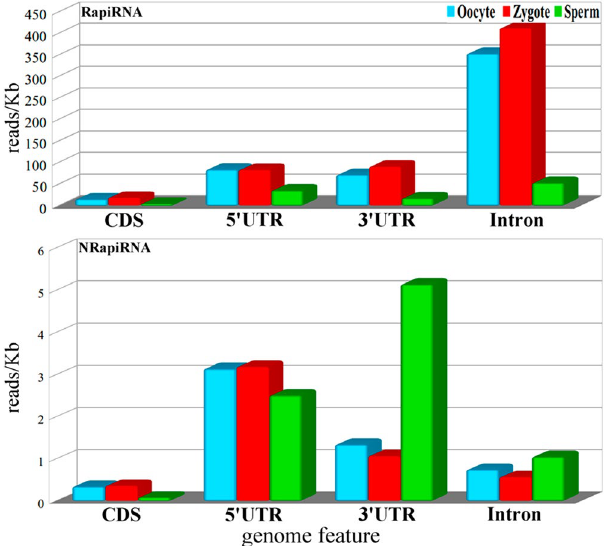
Figure 4. Genomic distribution of piRNAs associated and non-associated with repeat elements. Up-panel bar diagrams show the density distribution of read of piRNAs associated with repeat-element, whereas the down panel is displayed the piRNA non-associated with repeat elements (NRapiRNAs). piRNA density was calculated based on the number of the reads that mapped a feature according to Ensembl annotation divided by total bases present in these